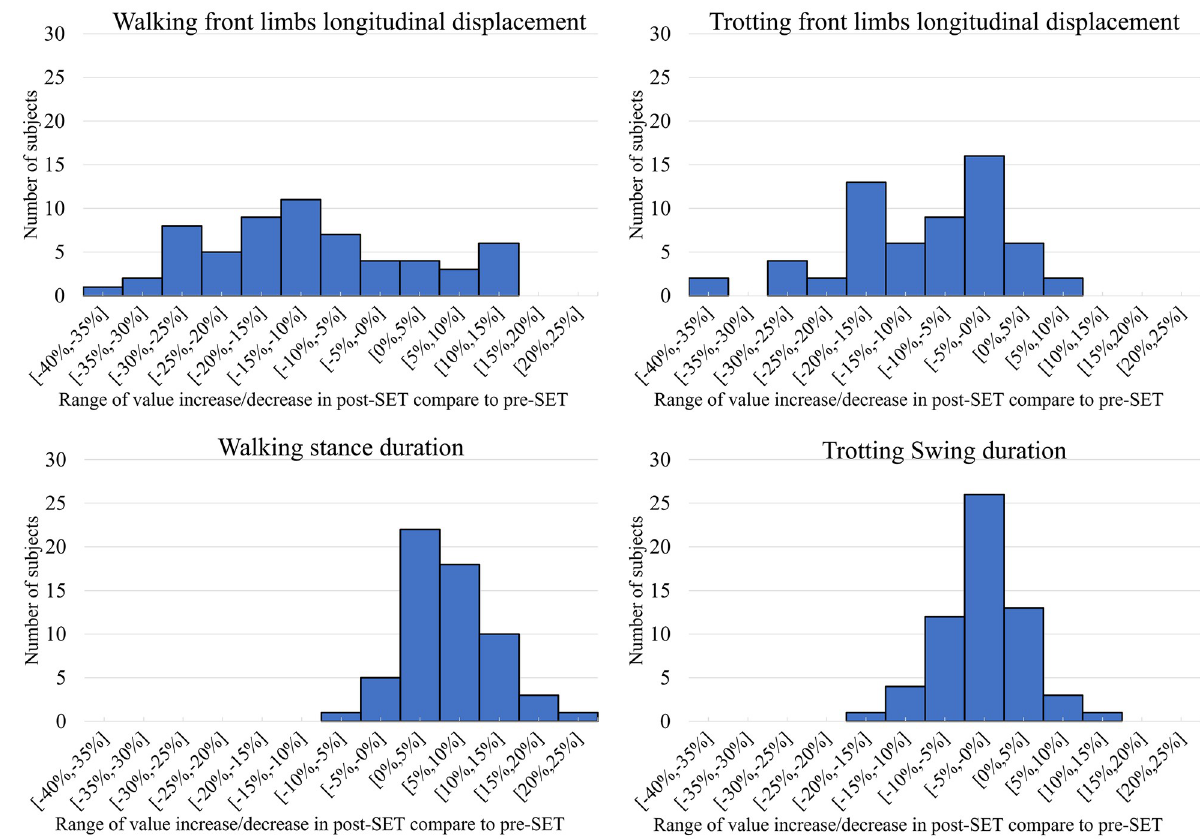
Fig 5. Number of horses with increased/decreased (in percentage) features values in post-SET compare to pre-SET. The vertical axes of all plots represents the range of increase (if positive) or decrease (if negative) of the specified feature value. Each bar represents the number of horses that have an increase or decrease of value within the specified range. Each plot consists of one value per horse, which was averaged from all strides of the